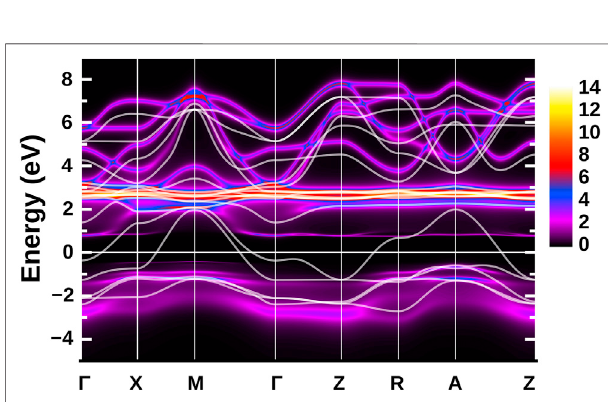
FIGURE8| BindingenergyfortopotacticalHascalculatedbynon – spin- polarized DFT and spin-polarized DFT + U for various transition metals B ( x -axis). Positive binding energies indicate that AB NiO 2 H is energetically favored; for negative binding energies, AB NiO 2 is more stable. The data for non – spin-polarized DFT calculations are from [55].